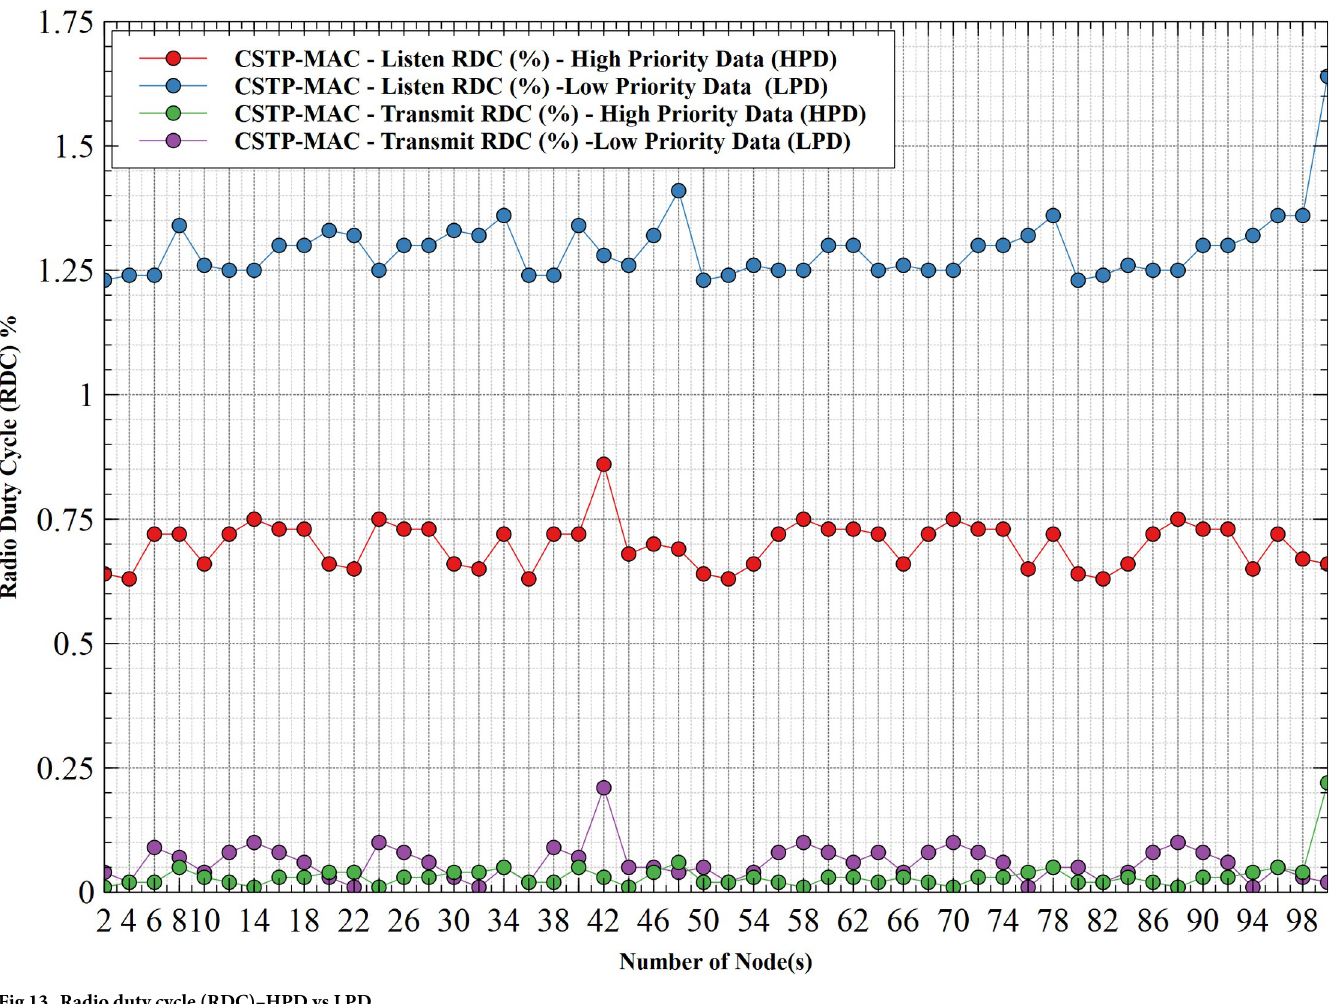
Fig 13. Radio duty cycle (RDC)–HPD vs